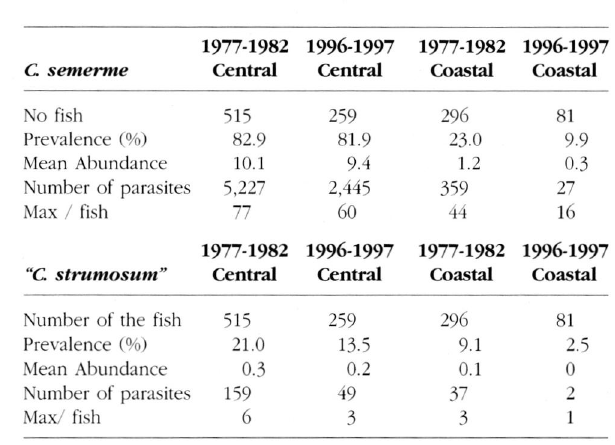
Table IV. - Comparison of C. semerme and "C. strumosum"infec tions between the periods of 1996 -1997 and 1977 -1982 in fourhorn sculpins from the Bothnian Bay. "C. stnimosum" included both C. magdaleni and C.